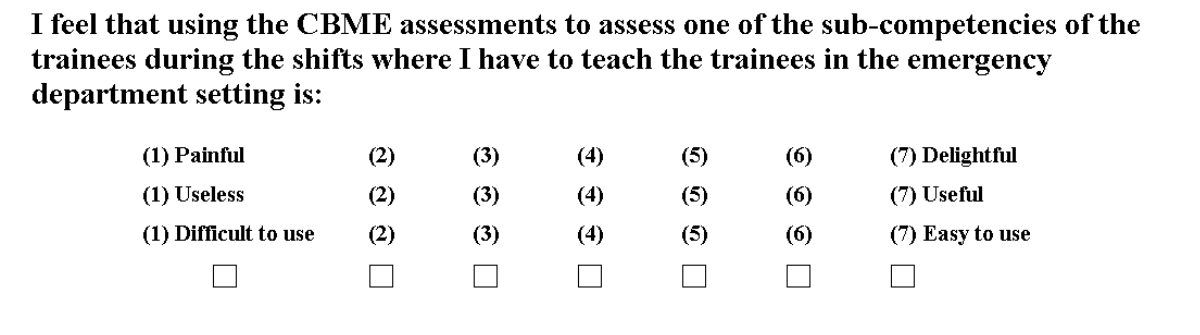
Figure 2. Example item of the questionnaire. CBME: competency-based medical